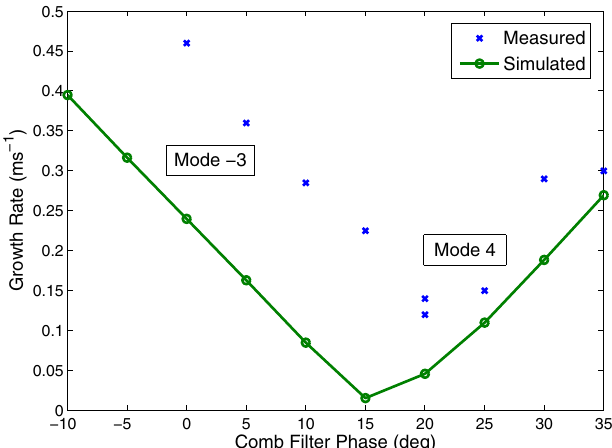
FIG. 13. (Color) Measured and simulated growth rates vs comb phase rotation for the LER at 1400 mA. Agreement in both the general form and most unstable mode